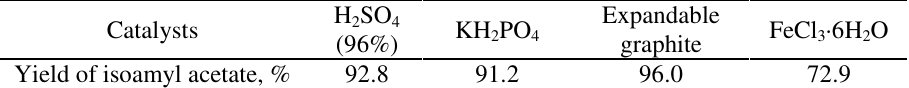
Table 4 . Influence of different catalysts on esterification